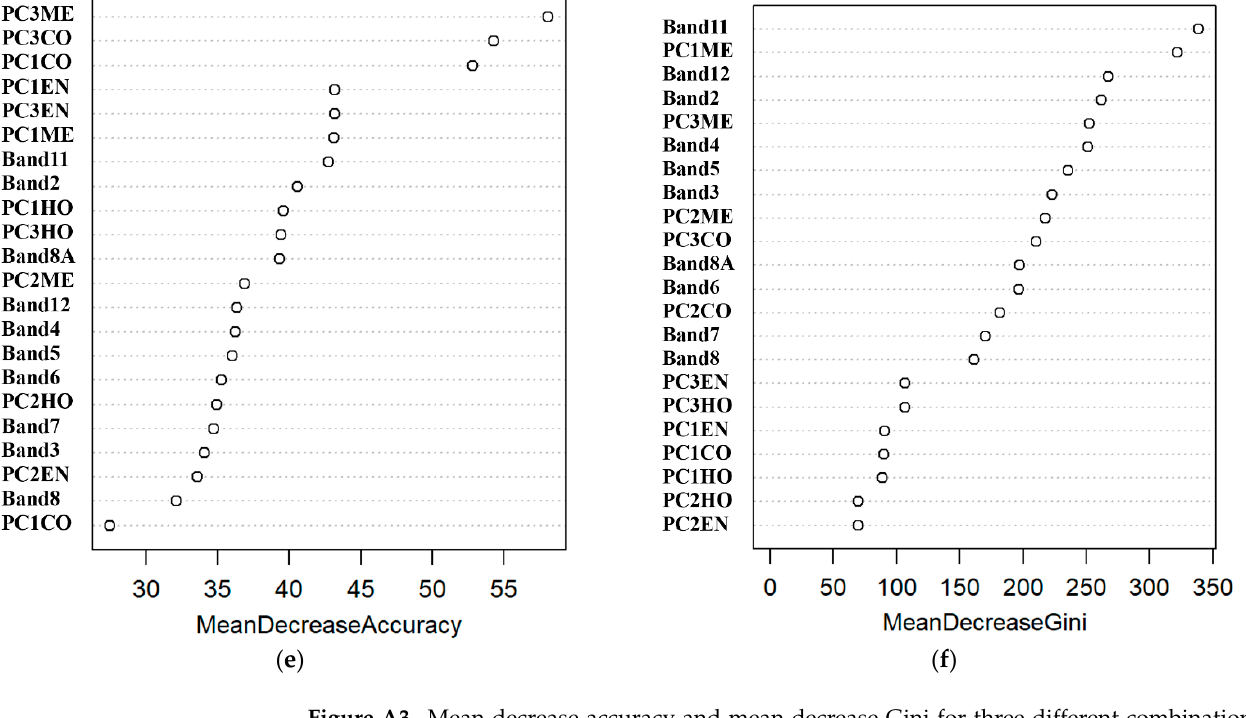
( e ) ( f ) Figure A3. Mean decrease accuracy and mean decrease Gini for three different combinations of variables: (I) Spectral bands ( a , b ), (II) Spectralbands + VIs ( c , d ), and (III) Spectralbands+ GLCM texture ( e , f ) . Table A3. Effect of sample size on OA, UA, PA, and Kappa in RF classification.